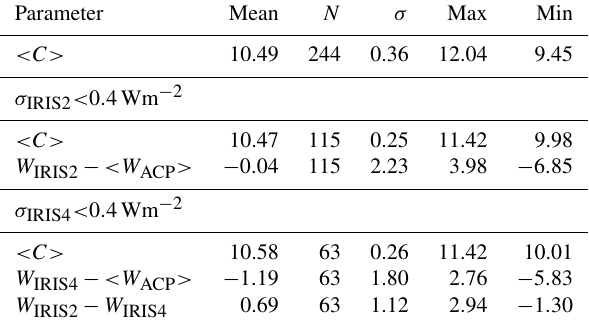
Table 6. Linear LSQ method results for ACP96 <C> using ε c = 0 . 0225, γ = 6 . 5 and τ = 0 . 977 and the difference between ACP96 and IRIS irradiances when coincident data were available ( W IRIS − <W atm > ). <C> statistics for all 244 linear LSQ calibrations are presented in the first data row. The second and third data rows con- cern periods when ACP96 and IRIS2 data were available; the fourth and fifth data rows concern periods when ACP96 and IRIS4 were available. The last data row gives the statistics of the irradiance dif- ferences between the two IRIS radiometers for 63d of coincident data.